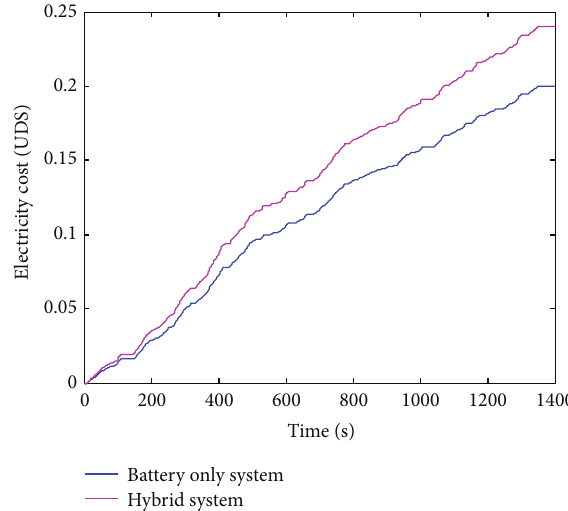
Figure 39: Comparison of the electricity cost based on UDDS driving cycle.